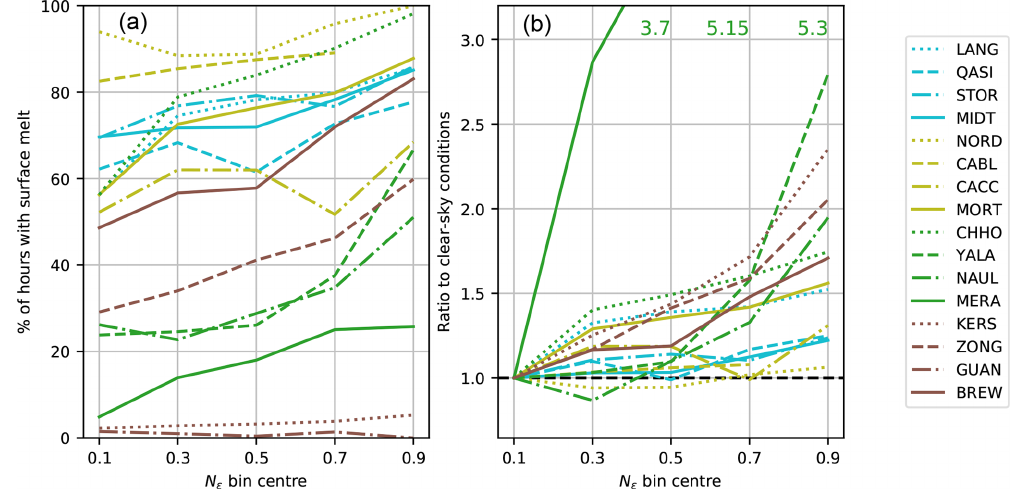
Figure 9. (a) Percentage of hours with surface melt for different cloud conditions ( N ε ) during the melt season. (b) As for (a) shown as a fraction with respect to clear-sky conditions ( N ε (cid:53) 0 . 2). Note that GUAN is excluded from (b) due to insufficient data points and that for clarity some points for MERA are shown as text within the panel.